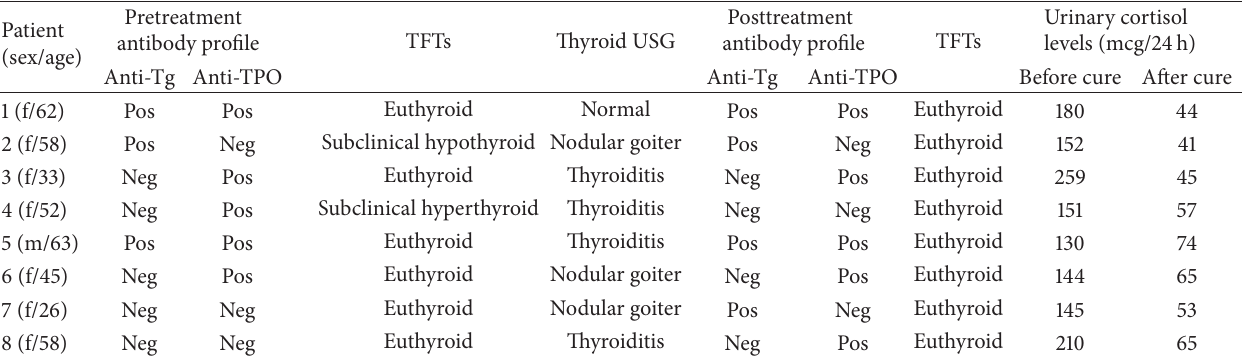
Table 2: Characteristics of 8 patients with Cushing’s syndrome who had evidence of thyroid autoimmunity during